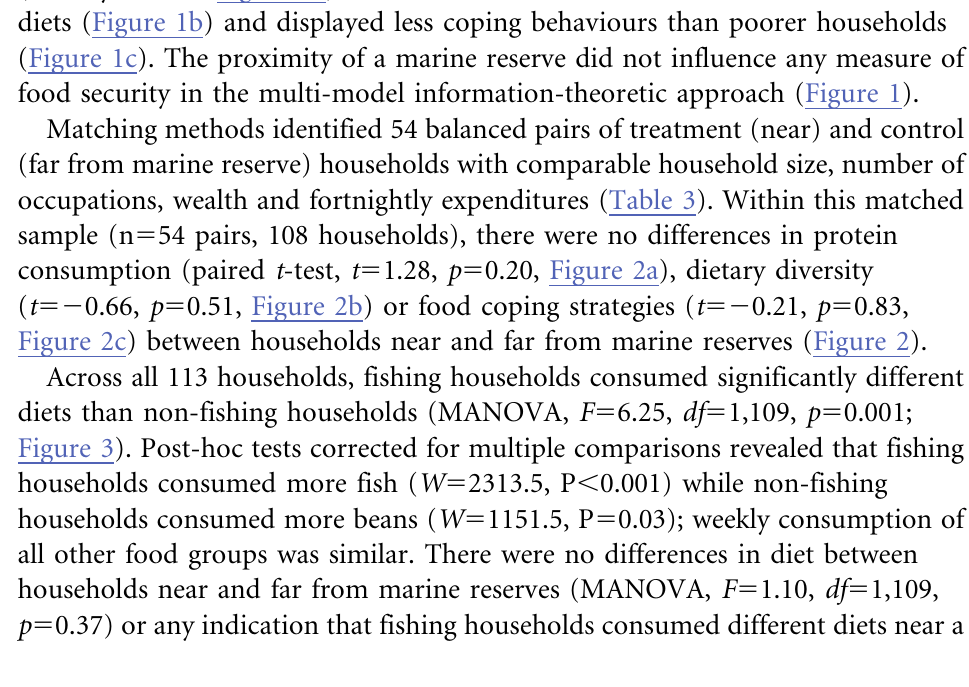
(3.5 days week 1 , Figure 1a) and wealthier households consumed more diverse diets (Figure 1b) and displayed less coping behaviours than poorer households (Figure 1c). The proximity of a marine reserve did not influence any measure of food security in the multi-model information-theoretic approach (Figure 1). Matching methods identified 54 balanced pairs of treatment (near) and control (far from marine reserve) households with comparable household size, number of occupations, wealth and fortnightly expenditures (Table 3). Within this matched sample (n 5 54 pairs, 108 households), there were no differences in protein consumption (paired t -test, t 5 1.28, p 5 0.20, Figure 2a), dietary diversity ( t 52 0.66, p 5 0.51, Figure 2b) or food coping strategies ( t 52 0.21, p 5 0.83, Figure 2c) between households near and far from marine reserves (Figure 2). Across all 113 households, fishing households consumed significantly different diets than non-fishing households (MANOVA, F 5 6.25, df 5 1,109, p 5 0.001; Figure 3). Post-hoc tests corrected for multiple comparisons revealed that fishing households consumed more fish ( W 5 2313.5, P , 0.001) while non-fishing households consumed more beans ( W 5 1151.5, P 5 0.03); weekly consumption of all other food groups was similar. There were no differences in diet between households near and far from marine reserves (MANOVA, F 5 1.10, df 5 1,109, p 5 0.37) or any indication that fishing households consumed different diets near a